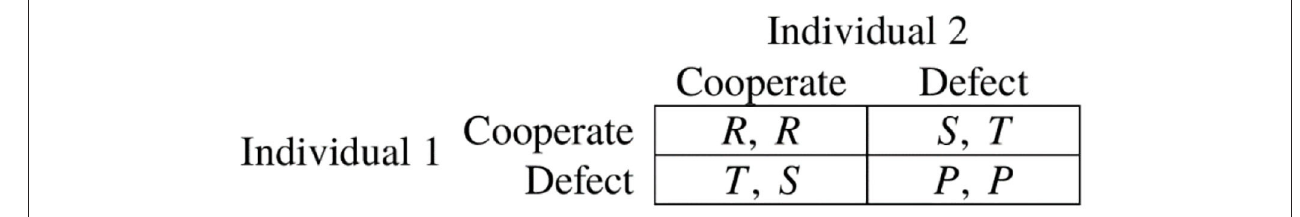
risk-averse than their counterparts from households with low socio-economic status.